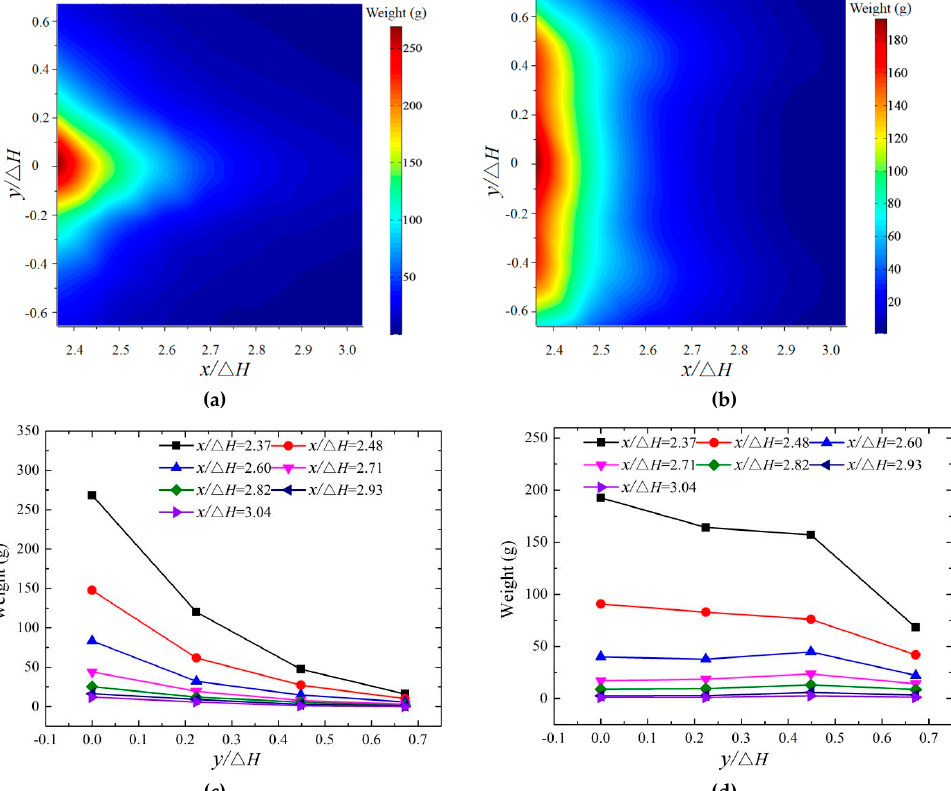
Figure 12. The downstream distribution of the splashing droplets (z/ Δ H = 0): (a, c) CB, (b, d) TB.